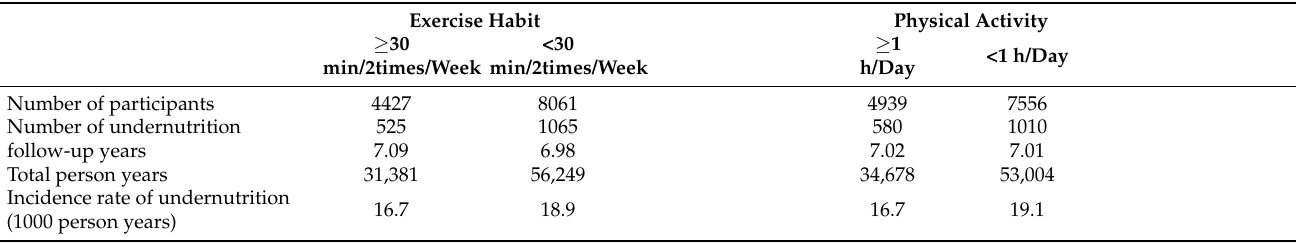
Table 3. Hazard ratios (95% CIs) of exercise habits for undernutrition incidence after disaster among 13,378 participants are stratified by each lifestyle and sociodemographic factor. Exercise